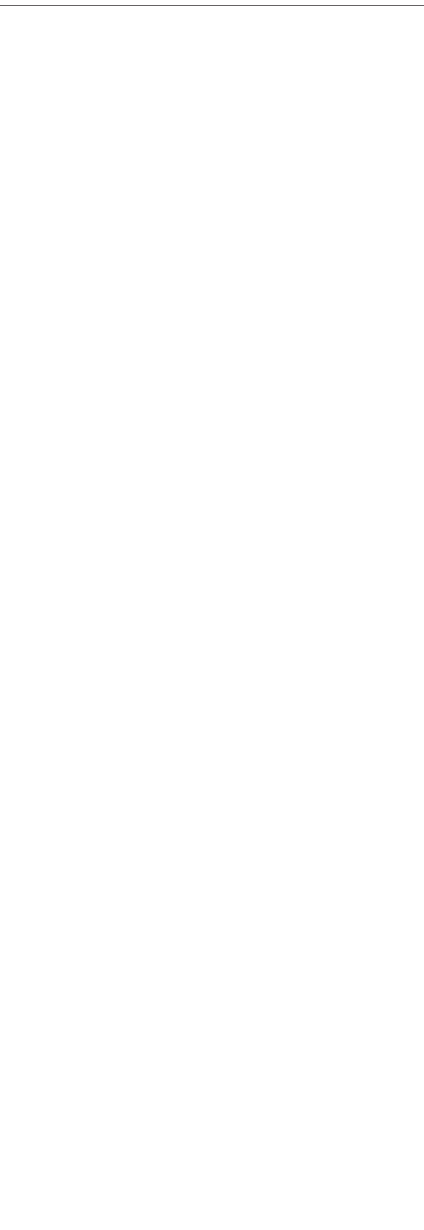
FIGURE 11 | Sequencing maps of the SNPs of PmGrx5